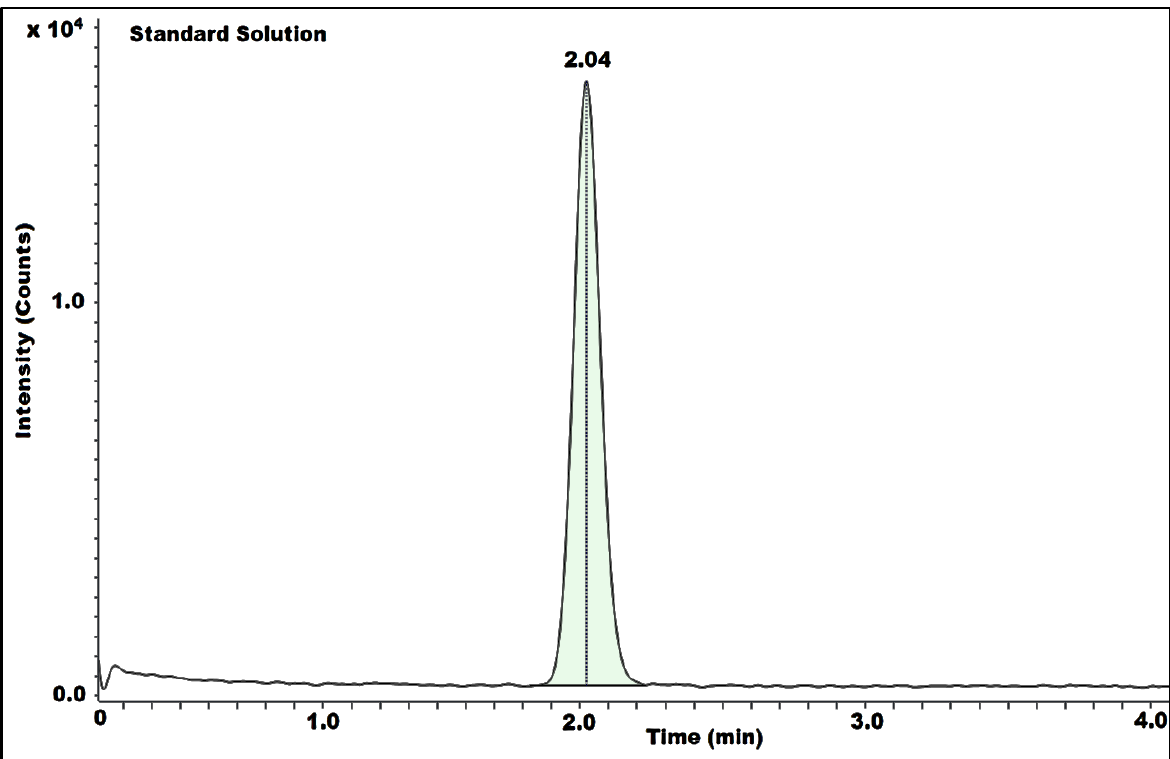
Figure 4. Allyl chloride standard solution chromatogram. Table 2. Summary of method validation results.